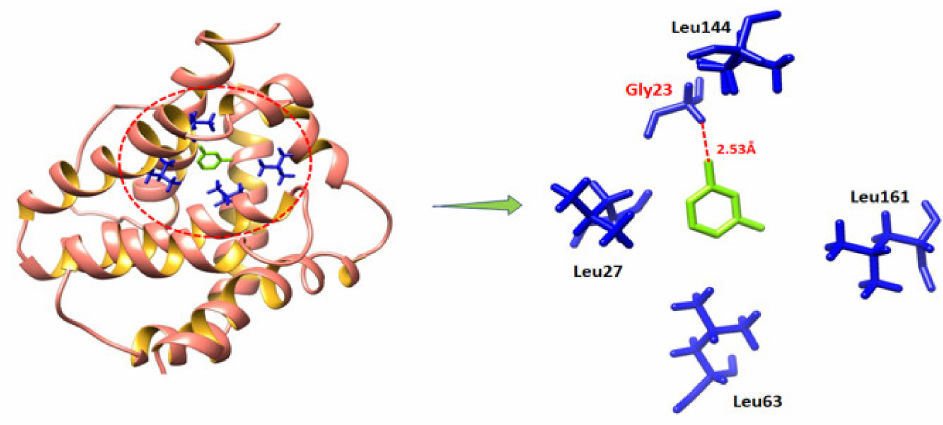
Figure 10. Binding analysis of MVL with BAX.